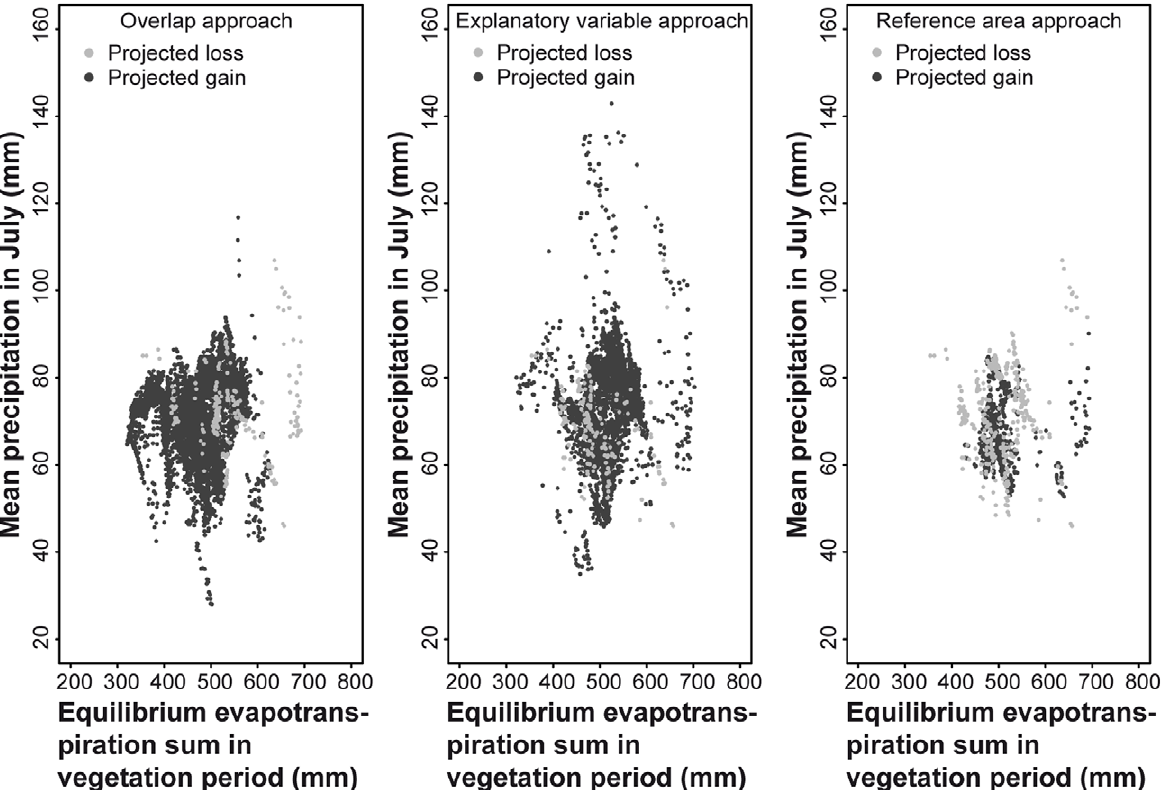
Figure 4. Projected future losses and gains of the current distribution of Aeshnaviridis in Europe. Losses and gains are shown for the three applied biotic interaction approaches depending on the two most range-influencing climatic variables (out of six variables; variable importance measured by BIOMOD). Climate model: HadCM3, emission scenario: A2, time period: 2021–50. The vegetation period ranges from March until